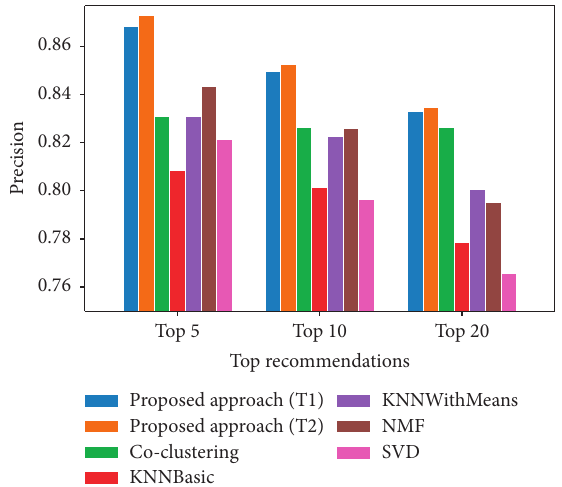
Figure 4: Precision at ( k ) where k � 5, 10, and